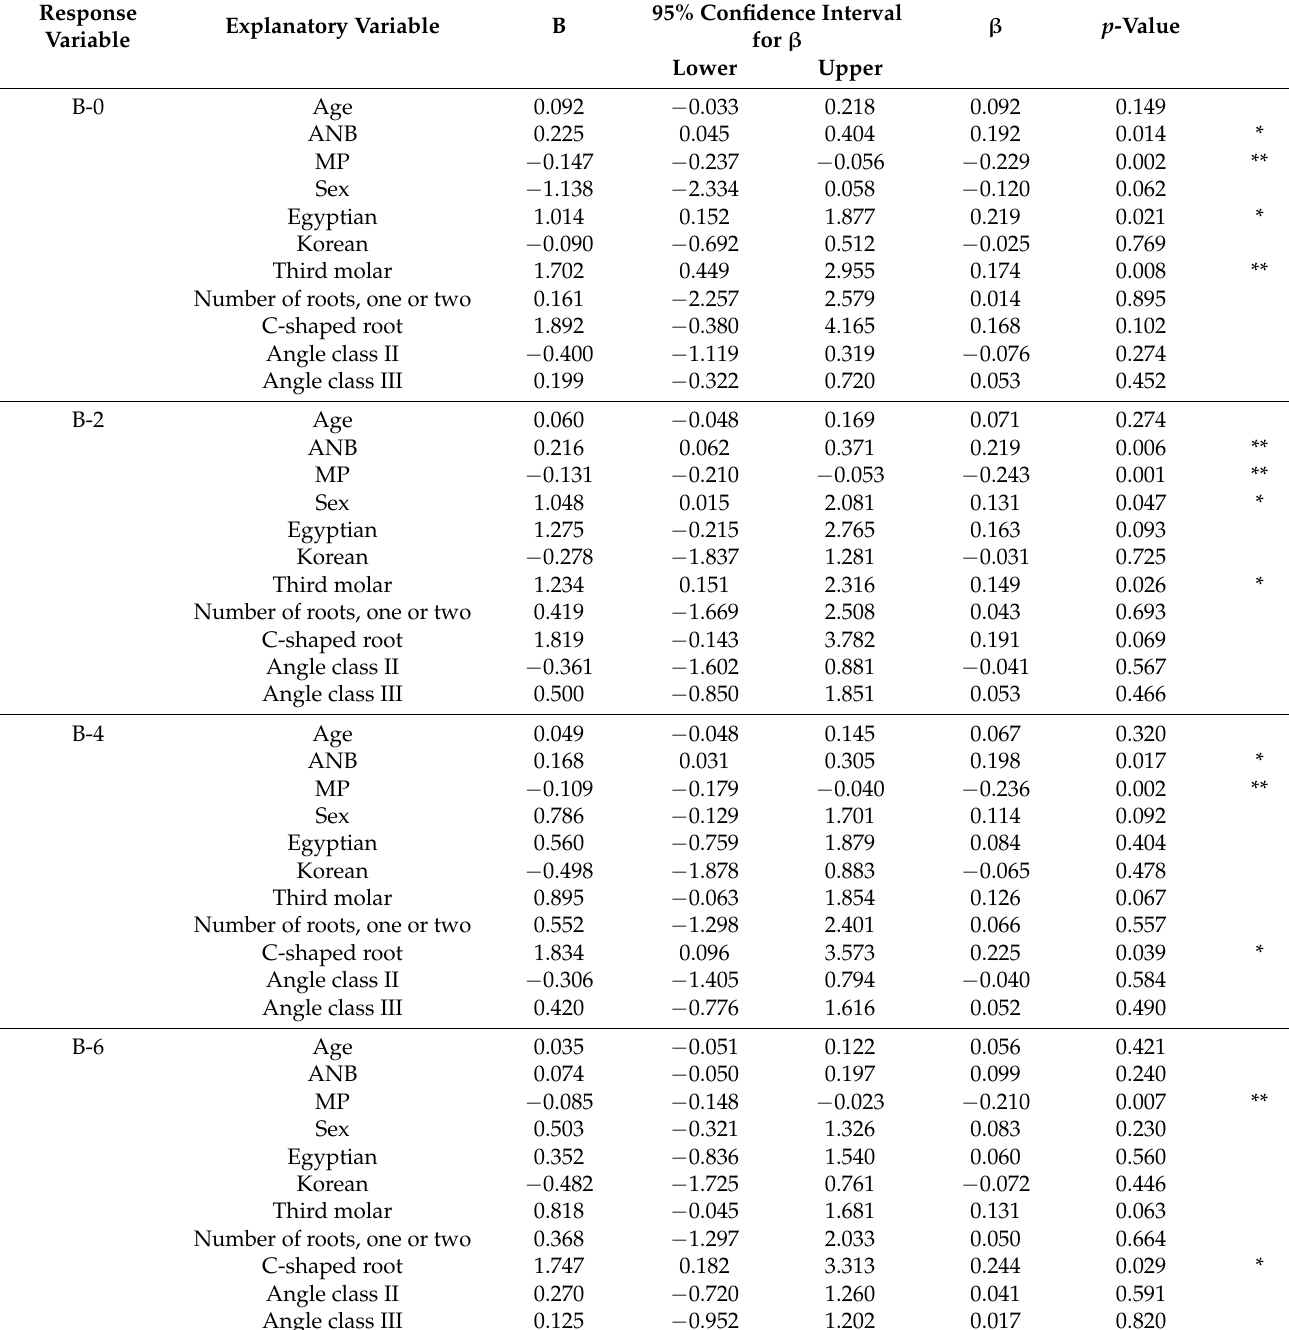
Table 4. Results of multiple regression analysis (cuspal